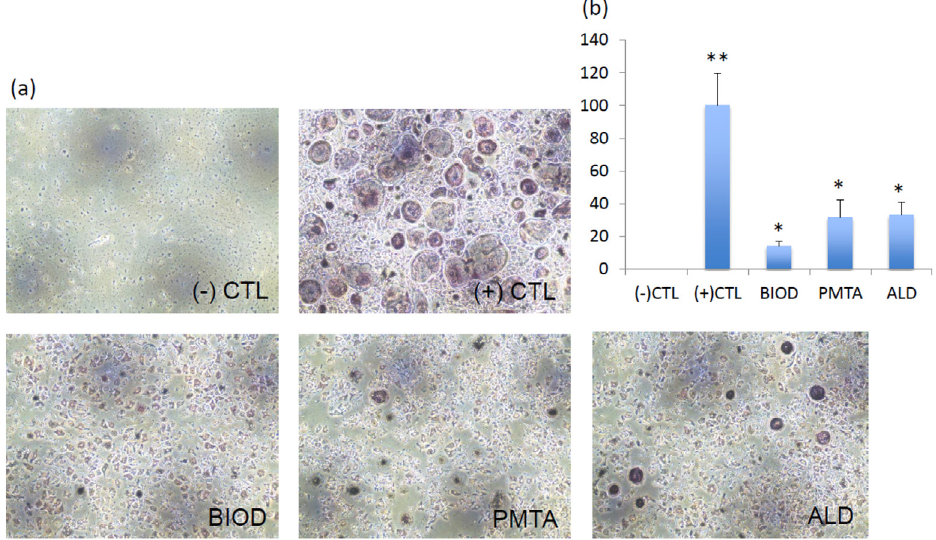
Figure 3- Tartrate-resistant acid phosphate (TRAP) staining of osteoclasts (OCLs) treated with or without CSCs or ALD. (a) Representative images of each group. (-) CTL, BMMs without RANKL/LPS treatment; (+) CTL, OCLs (BMMs treated with RANKL/LPS); BIOD, OCLs treated with Biodentine conditioned media; PMTA, OCLs treated with ProRoot MTA conditioned media; ALD, OCLs treated with alendronate. (b) Quantification of TRAP-positive osteoclasts. Number of TRAP-positive cells was significantly higher in (+) CTL (P<0.05), while no significant differences were observed between BIOD, PMTA, and ALD (P>0.05). Different asterisks (* and **) means that they were significantly different each other. BMMs=bone marrow macrophages; CSCs=calcium silicate-based cements; LPS=lipopolysaccharide; OCLs=osteoclasts; RANKL=receptor activator of NF-κB; TRAP=tartrate-resistant acid